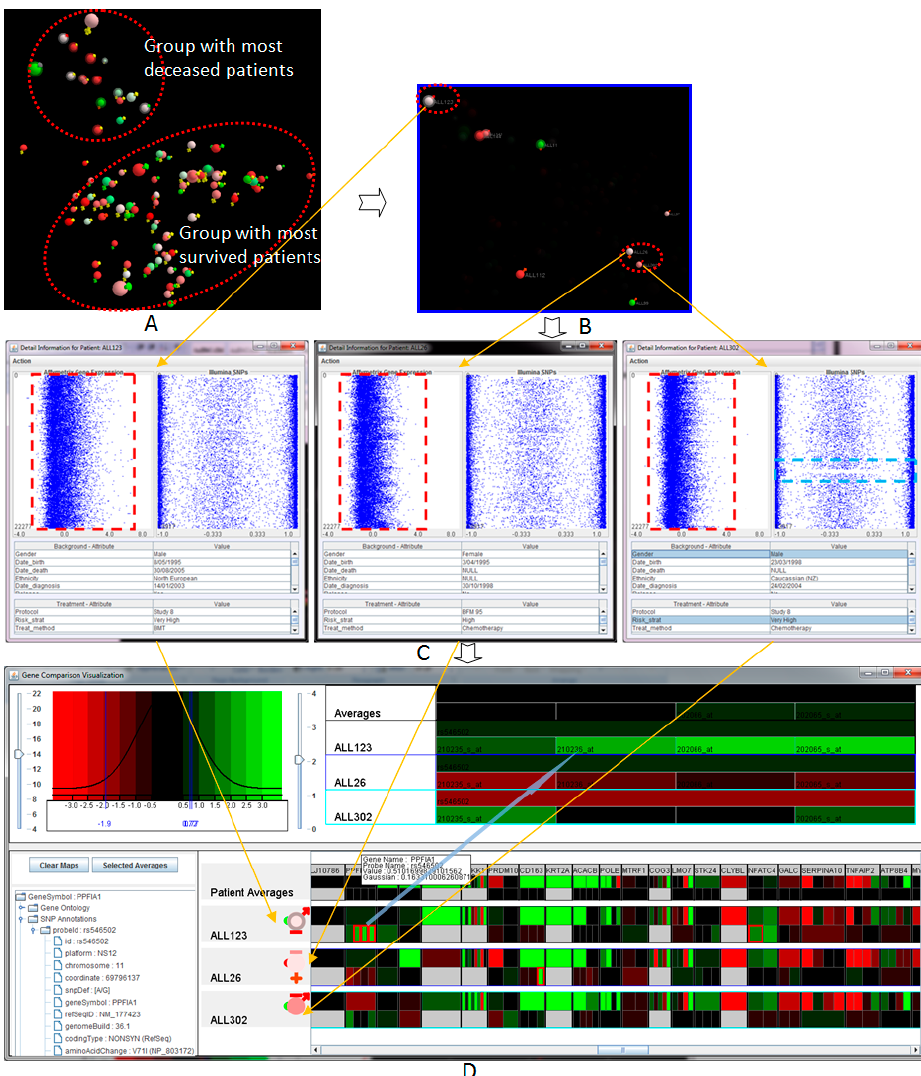
Figure 2. The seamless visual analysis from the overview of the entire patient population in the similarity space ( A ); focused patients at a navigational stage ( B ); to patient-to-patient comparison view of raw data outputs from a data collection step, ( left ) Affymetrix gene expression and ( right ) Illumina SNP, both ordered to chromosomal location ( C ) and, finally, to the genes of interest view ( D ).